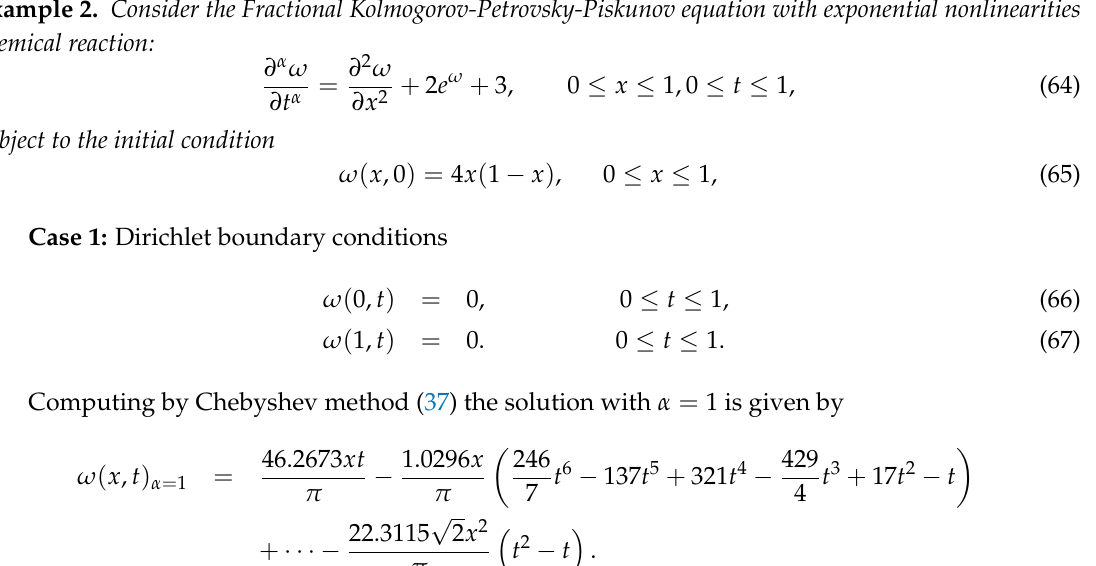
t = 0.8 t = 0.9 Figure 4. Graphs of absolute errors for Fisher equation at t = 0.8 and t =